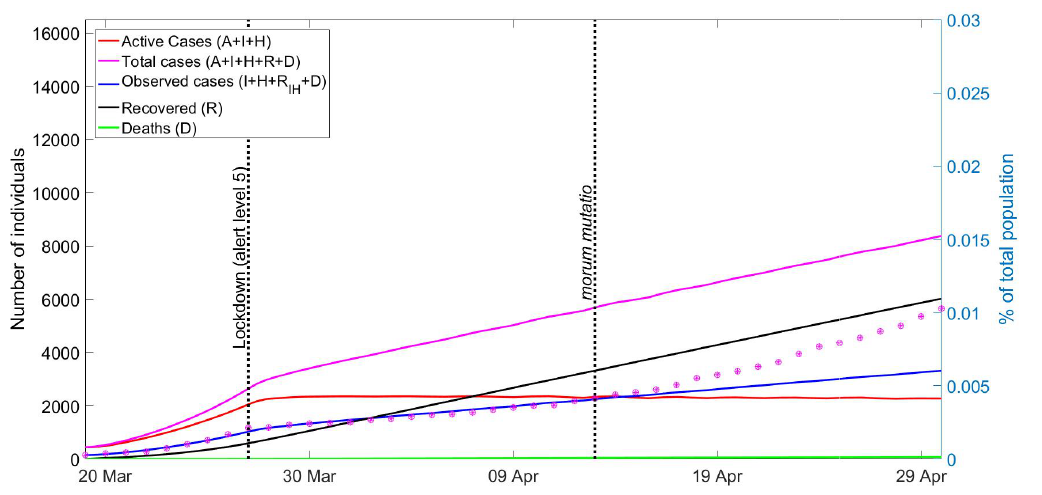
Fig. 3. COVID in South Africa: Lockdown